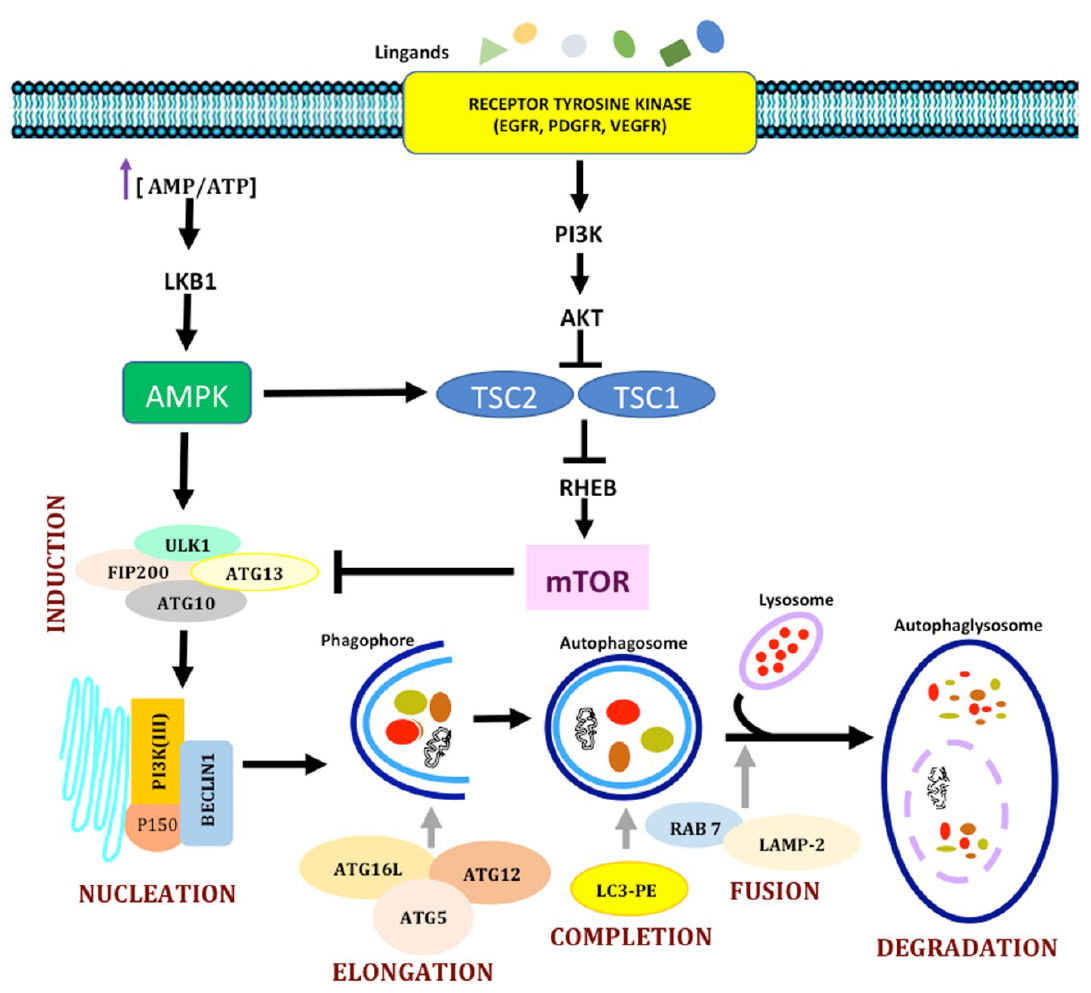
Figure 4. Schematic pathway of autophagy. Autophagy consists of several stages: induction, auto-phagosome nucleation, elongation and completion, fusion to lysosome, and degradation and recycling. Under nutrient-rich conditions, mTOR inhibits autophagy by inactivating the complex kinase-kinase ULK1/2; upon mTOR inactivation due to lack of nutrients, growth factor deprivation, or stress, autophagy is induced; the initial step requires the activity of the PI3K-III/ Beclin-1 complex. The completion and expansion of the autophagosome requires the Atg5/Atg12/Atg16 and LC3-PE proteins. The mature autophagosome fuses with a lysosome to form the autophagosome, which requires the action of several proteins, such as Rab7 and Lamp 1, 2. Black arrows ( ↓ ) mean activation and, black truncated arrows ( ⊥ ) mean inhibition. Up purple arrow means overexpression ( ↑ ) and short gray arrows mean participation in each step.